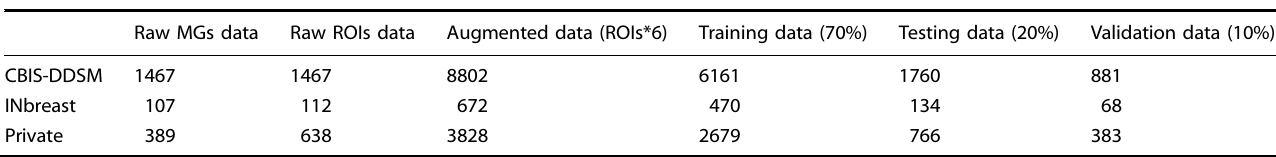
Table 1. Data distribution of the mammography